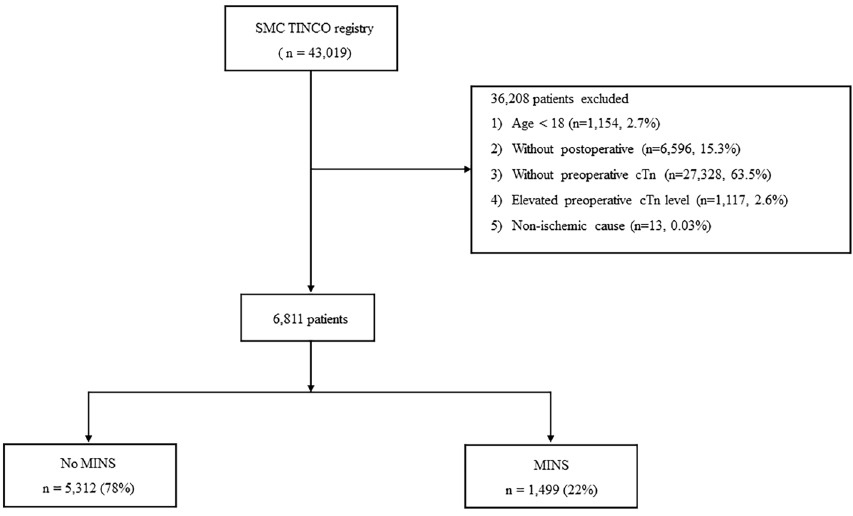
Figure 1. Study patient